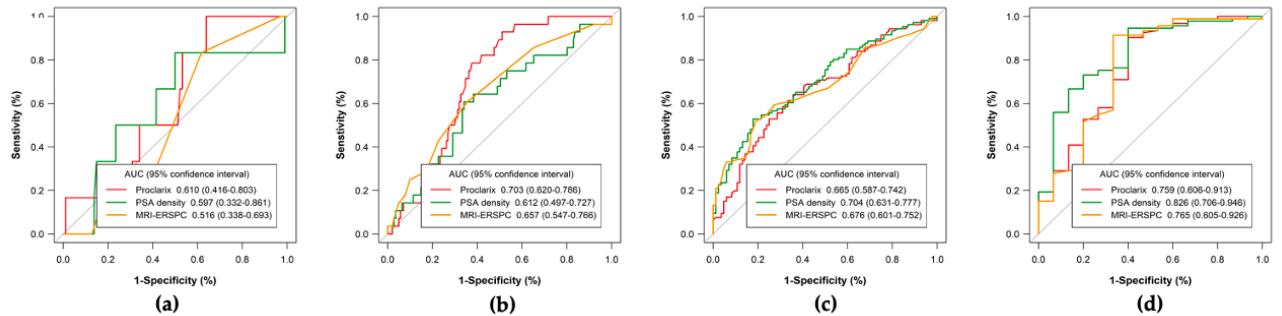
Figure 2. Efficacy of Proclarix, PSAD, and MRI-ERSPC model for csPCa detection regarding PI-RADS categories. PI-RADS < 3 ( a ), PI-RADS 3 ( b ), PI-RADS 4 ( c ), and PI-RADS 5 ( d ).